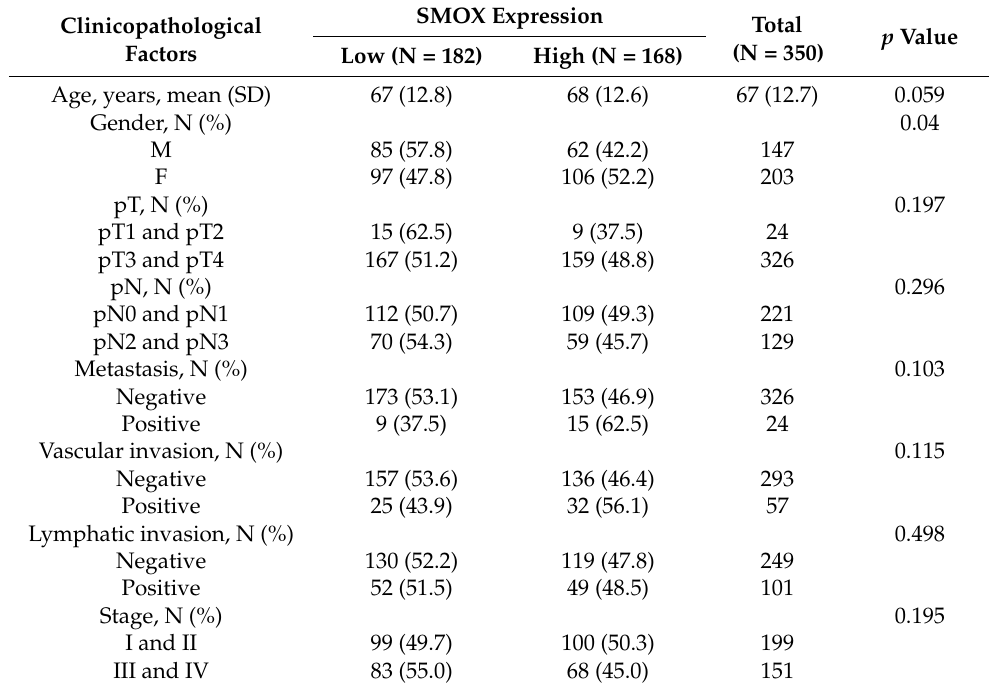
Table 1. Comparison of clinicopathological factors and SMOX expression in patients with